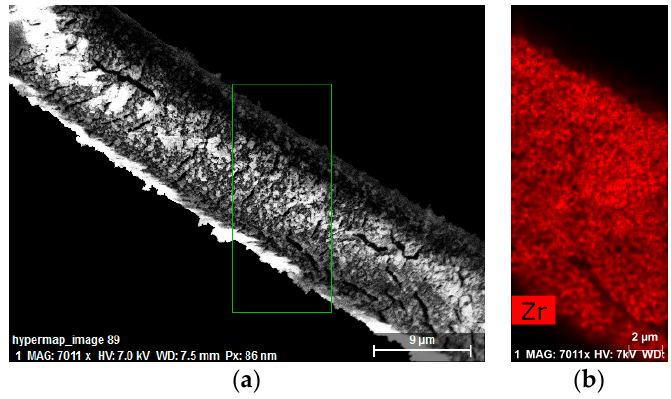
Figure 5. ( a ) Scanning electron microscopy (SEM) image of a cotton fiber functionalized with UiO-66 with the energy-dispersive X-ray spectroscopy (EDX) mapped region highlighted in green; ( b ) EDX zirconium map of the highlighted area shown in ( a ).